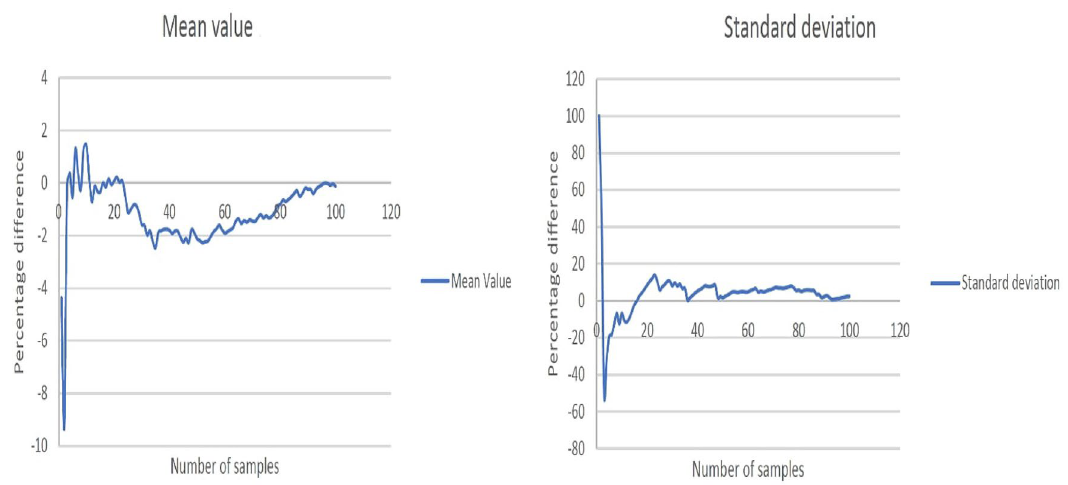
Fig. 6 Convergence of the mean value and the standard deviation of a randomly selected Monte Carlo simulation for the output failure load. The reference value of the percentage difference is the statistical moment in the 100